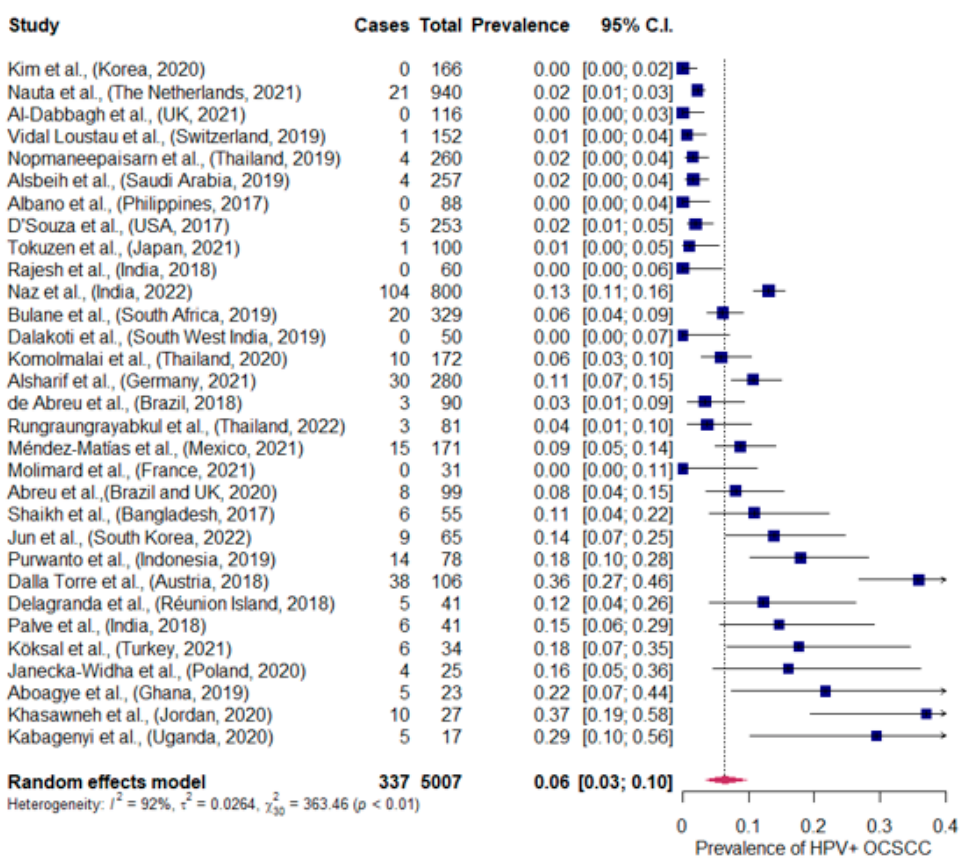
Figure 2. Meta-analysis of the HPV+ OCSCC prevalence in the included studies, representing the present HPV+ OCSCC prevalence worldwide [19–49]. HPV+: human papillomavirus positive. OCSCC: oral cavity squamous cell carcinoma. 95% C.I: confidence